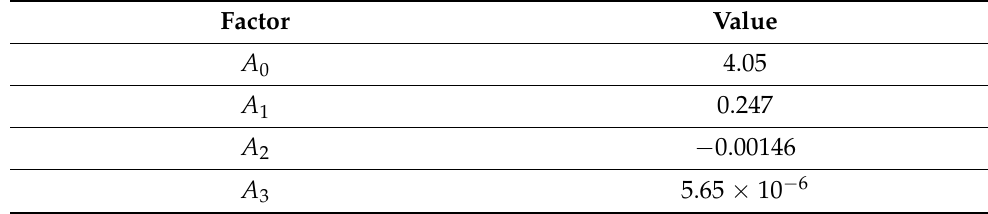
Table 3. Coefficients used for losses